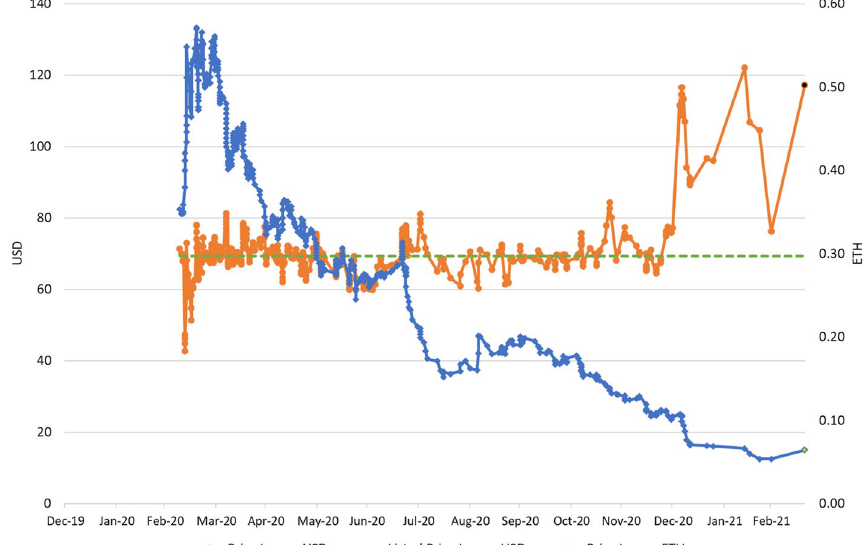
Fig. 15 Price (in USD and ETH) of 20,200 Lesure Street Detroit MI. Each dot represents one transaction. Last colored dot is ask price on